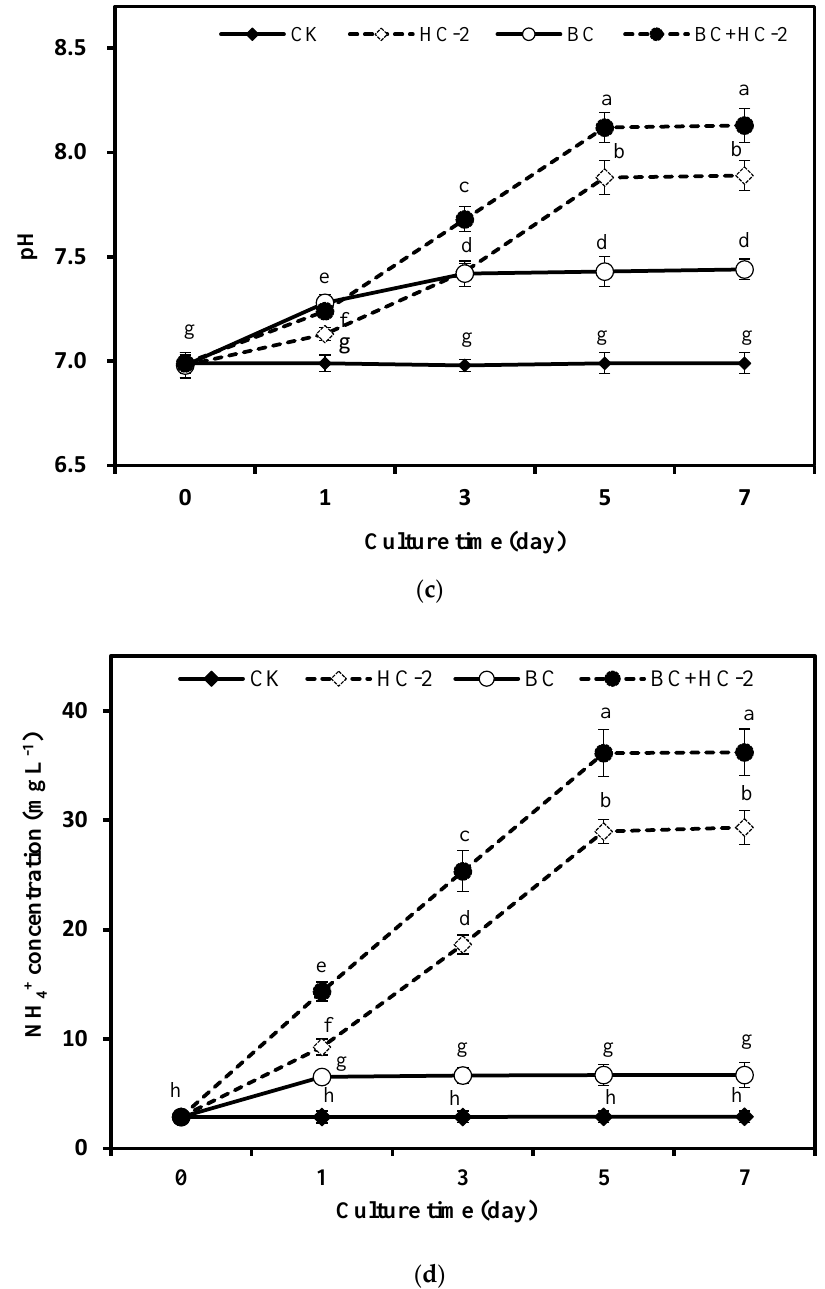
Figure 1. Changes in Cd and Pb concentrations, pH, and NH 4+ concentrations in the culture solution with strain HC-2 and BC. a : the influence of different treatments on the concentration of water-solution Cd. b : the influence of different treatments on the concentration of water-solution Pb. c : the influence of different treatments on the pH of the solution. d : the influence of different treatments on the NH 4+ concentration of the solution. Error bars are ± standard error ( n = 3). Data followed by the different letters (a–h) are significantly different ( p < 0.05) according to Tukey’s test.